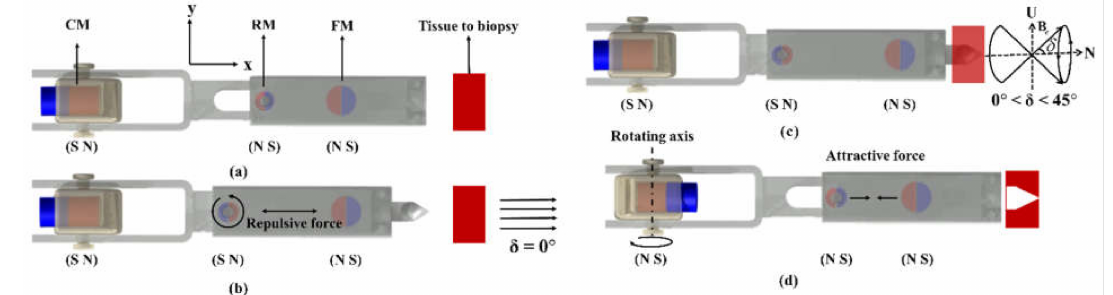
Figure 5. ( a ) CMR with needle covered to reach a target area. ( b ) Uncovering motion of CMR to expose the needle. ( c ) Crawling motion to puncture the tissue with external precessional magnetic field. ( d ) CMR with covered needle and collected sample heading backward to return to the starting